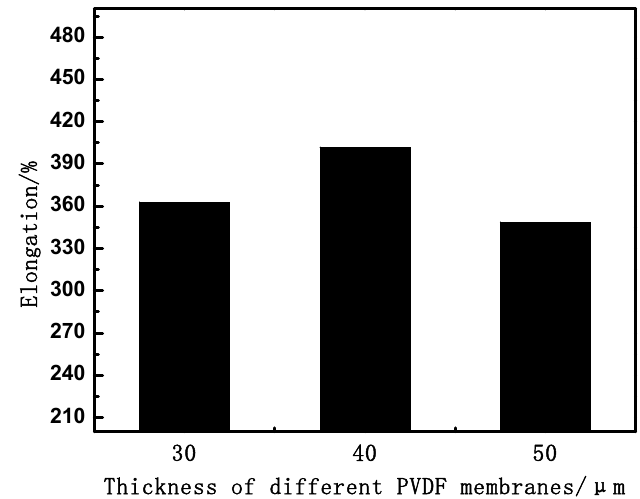
Figure 8. The effect of thickness on tensile elongation.